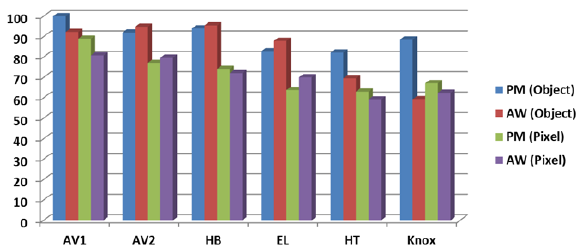
Figure 12: Object and area-based correctness comparison for roof plane extraction process.